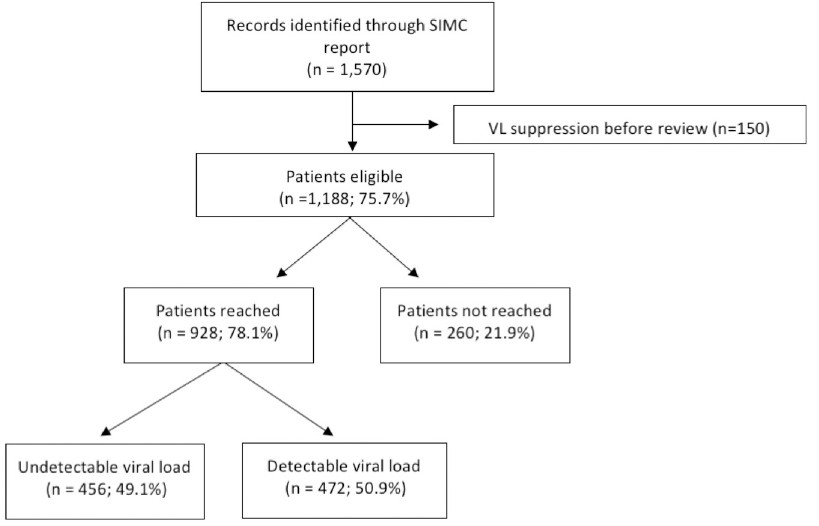
Fig 5. Flow diagram of patients with virologic failure during the intervention.